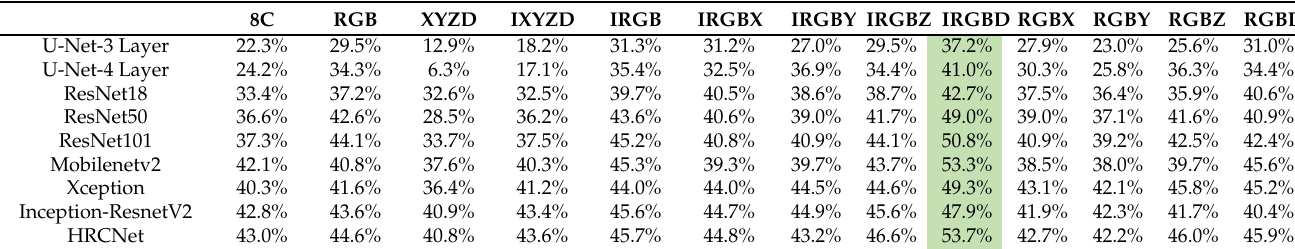
Table 4. The mIoU of seven networks regarding different combinations of channels (the highest mIoU for each network is marked as